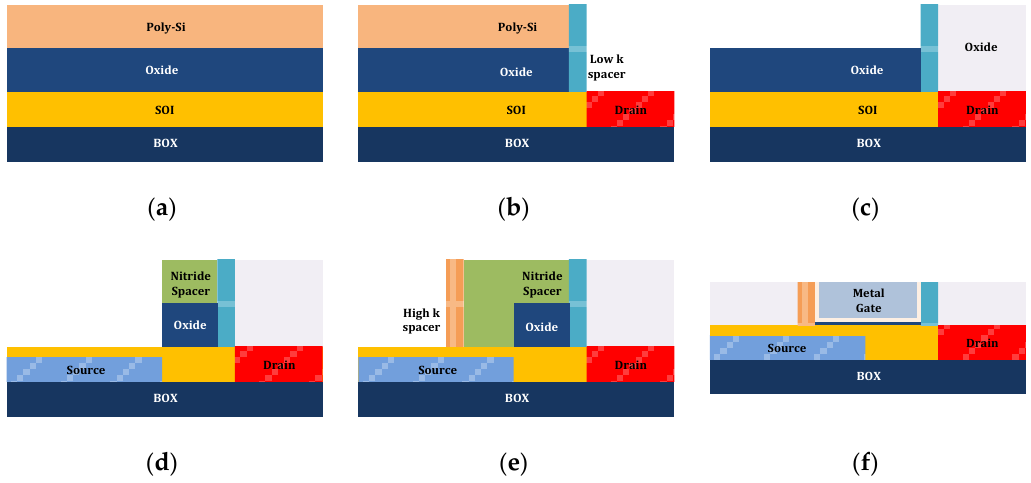
7 of 9 Figure 7. ( a ) Gate-to-drain capacitance-voltage characteristics at V DS = 0.0 V with symmetric high-κ spacer (κ = 25) and asymmetric high/low-κ spacer (κ = 25/3.9). ( b ) Inverter response characteristics with symmetric low-κ spacer (blue), symmetric high-κ spacer (green), and asymmetric high/low-κ spacer (red). Furthermore, the additional 10% improvement is achieved by the reduced gate-to-drain capacitance using the drain-side low-κ spacer. The proposed tunnel FET structure can be integrated as shown in Figure 8. First, oxide/poly-Si are sequentially deposited on silicon-on-insulator (SOI) wafer for the asymmetric spacer process (Figure 8a). After the drain-side is opened by photolithography and etching, the low-κ spacer is formed using deposition and etching. Then, self-aligned drain is defined using ion implantation process (Figure 8b). To passivate the drain side during subsequent processes, oxide is deposited on the whole region and the oxide planarization is performed by the chemical mechanical polishing (CMP) process. For the line tunneling region under a part of gate region, nitride spacer is formed on the oxide as a hard mask after the poly-Si is fully removed by using chemical etchant (Figure 8c). The oxide and partial SOI etching are carried out in sequence, and ion is implanted for the source region. On the partially etched SOI region, the selective epitaxy growth (SEG) layer, which can enhance tunneling current, can be deposited without doping (Figure 8d). After that, dopant activation is adapted and nitride spacer formation is applied again, which can determine the line tunneling area